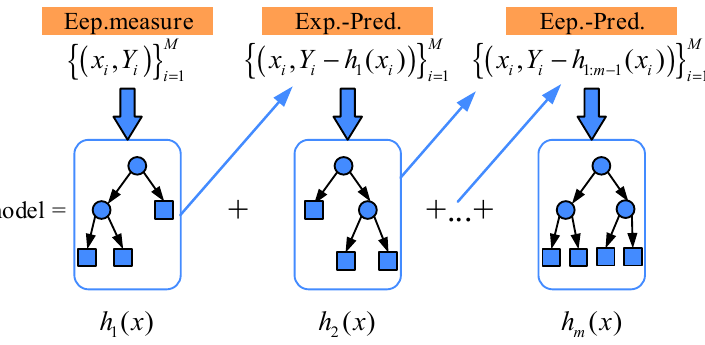
Figure 1. Schematic of tree-based gradient boosting.